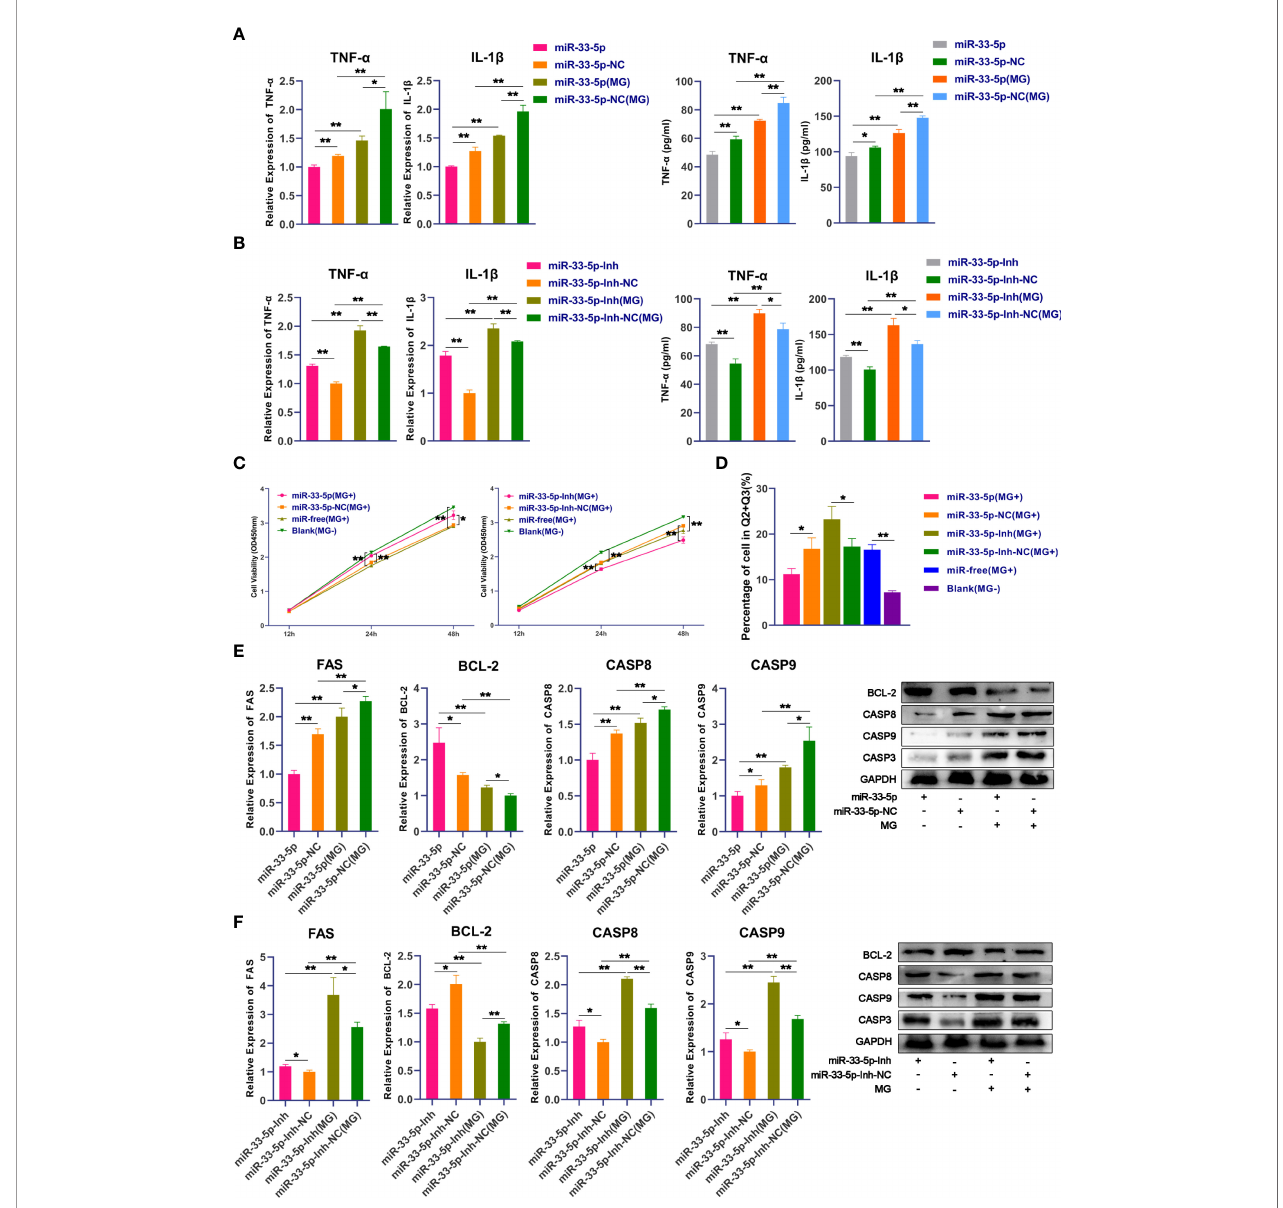
FIGURE 3 | miR-33-5p inhibits MG infection-induced in fl ammation and apoptosis. DF-1 cells were transfected with the indicated RNA oligonucleotides and infected with MG. (A) The expression levels of pro-in fl ammatory cytokines (TNF- a and IL-1 b ) after treatment with miR-33-5p mimics were detected by qPCR and Elisa; (B) The expression levels of pro-in fl ammatory cytokines (TNF- a and IL-1 b ) after treatment with miR-33-5p inhibitor were detected by qPCR and Elisa; (C) CCK-8 kit was used to detect cell proliferation at 12, 24, 48h post-infection; (D) The cells were stained with Annexin V- PI and analyzed by fl ow cytometer after 24h post- infection; (E) The expression of apoptosis marker genes after treatment with miR-33-5p mimics was detected by Western blot and qPCR; (F) The expression of apoptosis marker genes treatment with miR-33-5p inhibitor was detected by Western blot and qPCR. GAPDH was used as the internal control. Data was expressed as the mean ± SD of three independent experiments, each with three replicates. (* p < 0.05, ** p <